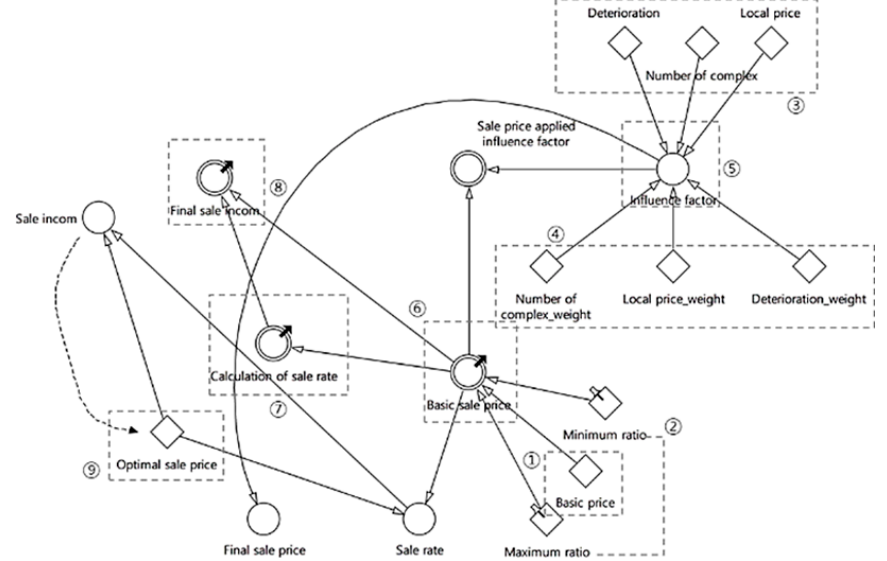
Figure 11. Developed simulation model.